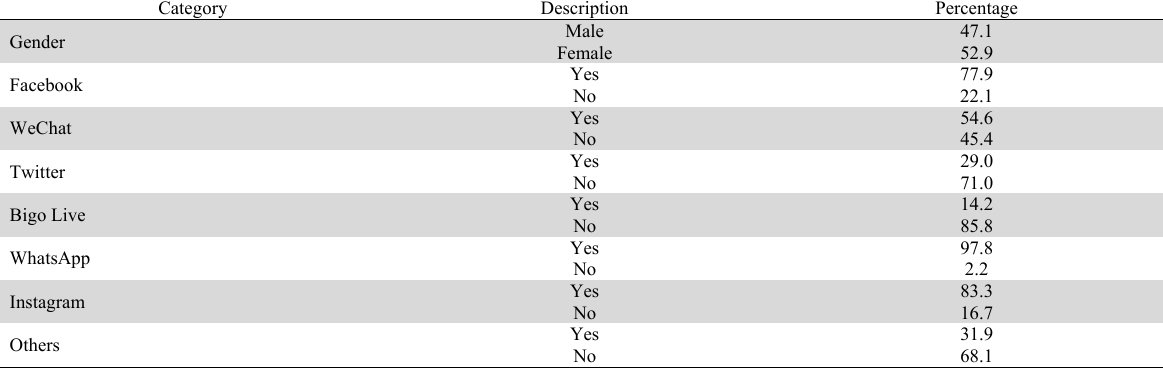
Results of Social Media Categories used by Teenagers